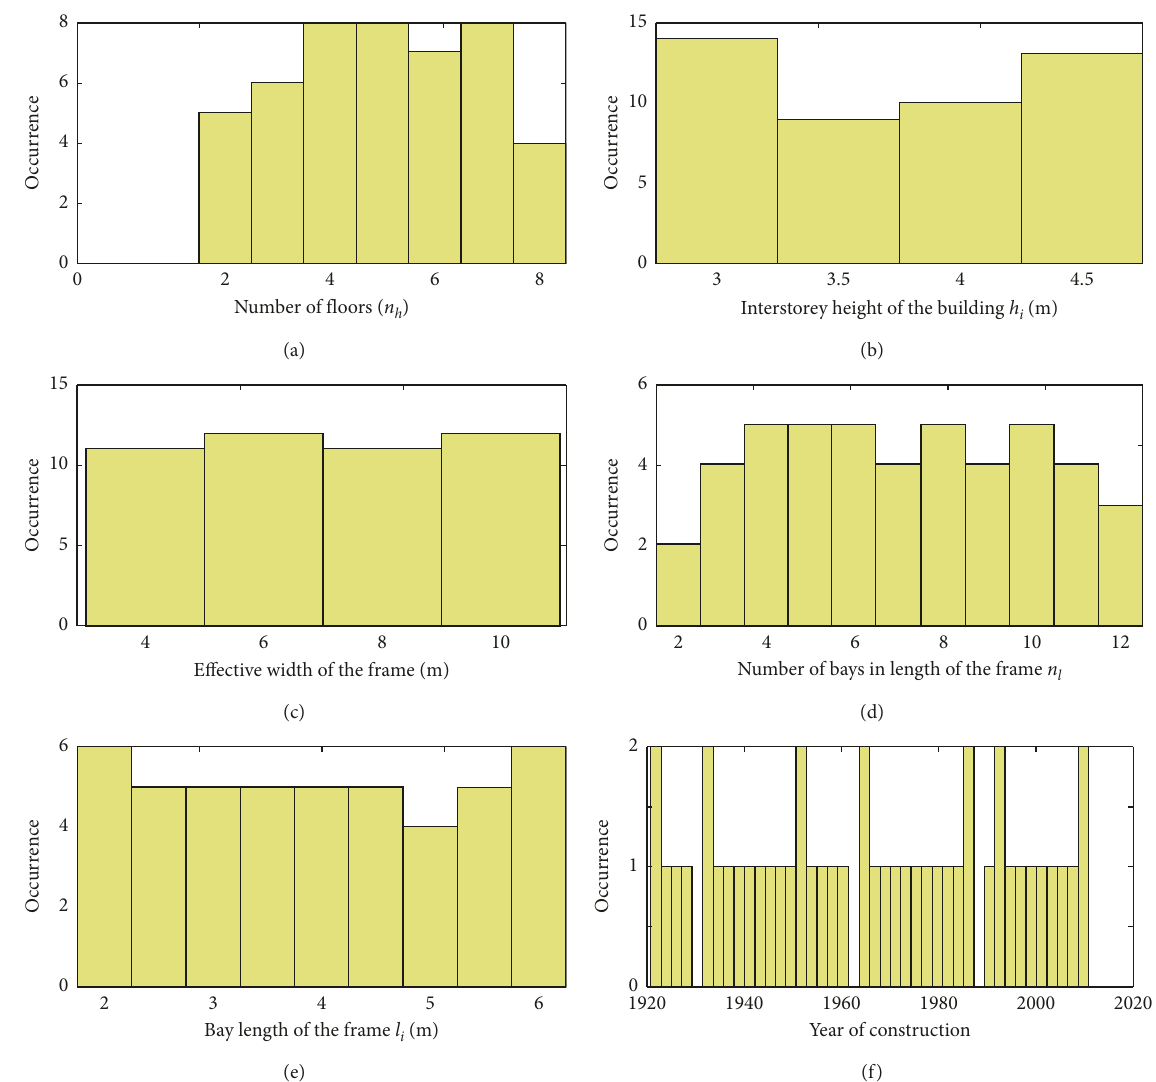
Figure 6: (a–f) Histogram of randomly selected input variables (geometry-based variables).